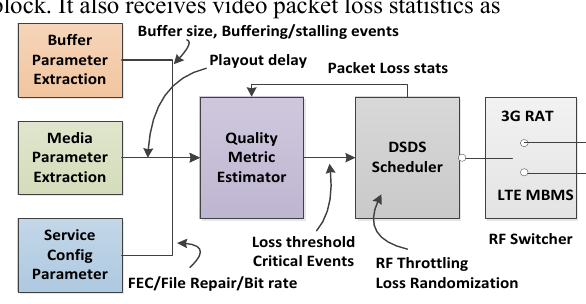
Figure 2 . Structure for Optimized MBMS-DSDS capable